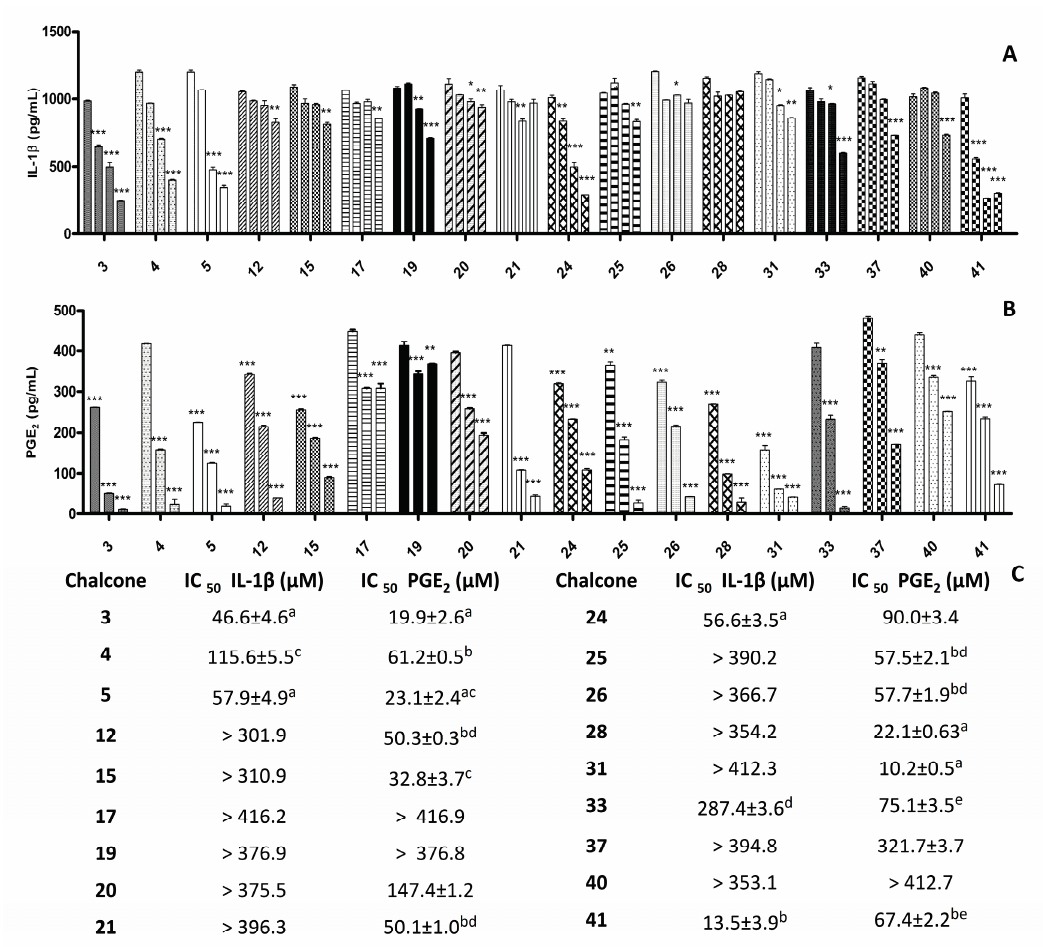
Figure 1. Effect of substituted chalcones on production of proinflammatory mediators (IL-1 β and PGE 2 ) by LPS-stimulated RAW 264.7 macrophages. RAW 264.7 cells were